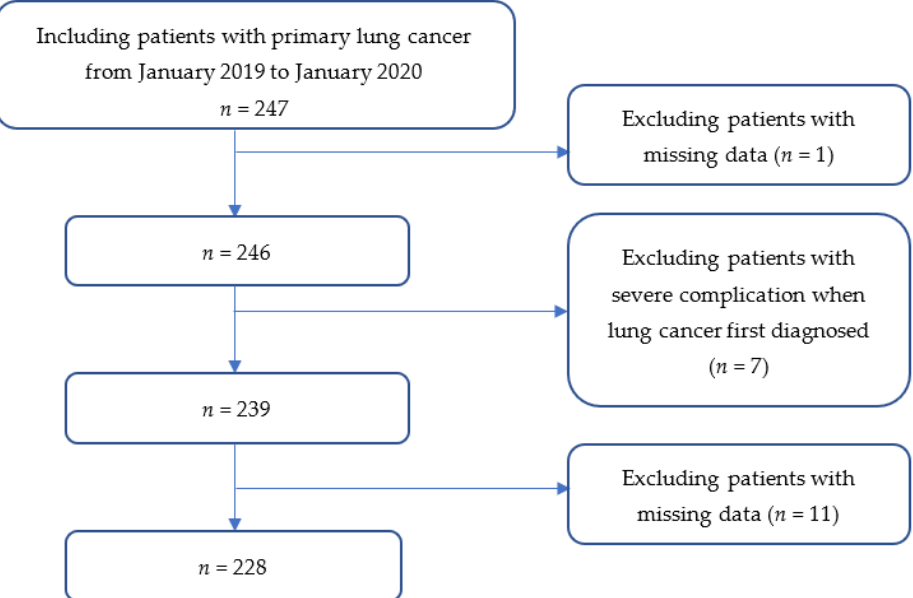
Figure 1. Enrollment and follow-up of the patients until 1 July 2022 or until patient